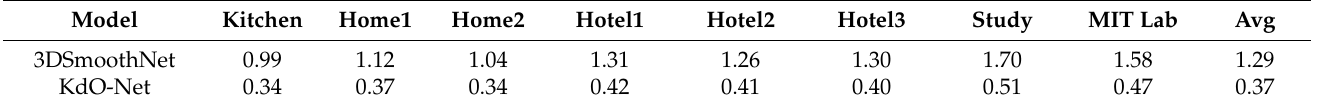
Table 2. Average nearest neighbor searching time per interest point on each scene of 3DMatch test set